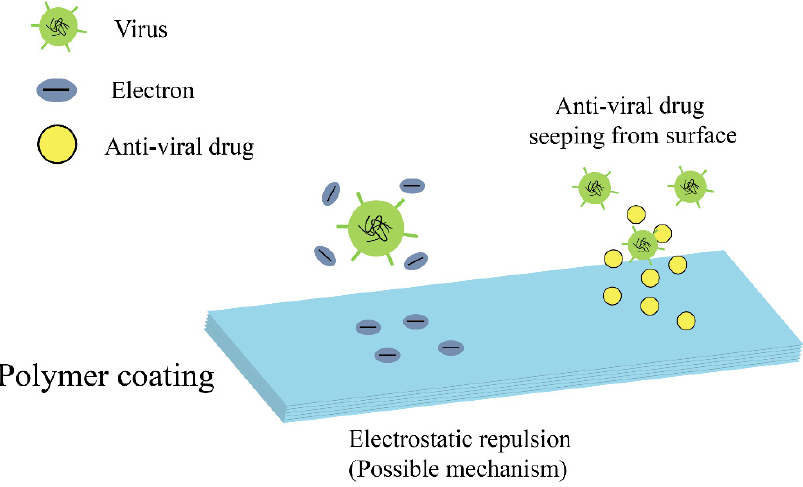
Figure 2. Schematic demonstration of the antiviral mechanism of polymer coatings.